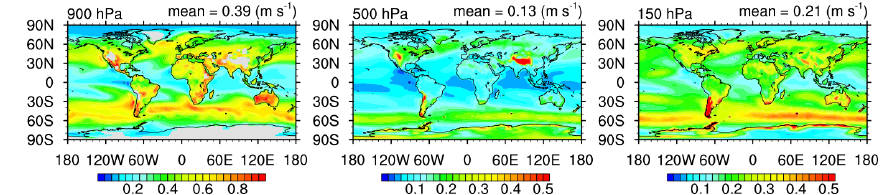
Figure 4. Annual mean subgrid vertical velocity standard deviation, σ w , for the NEW run.